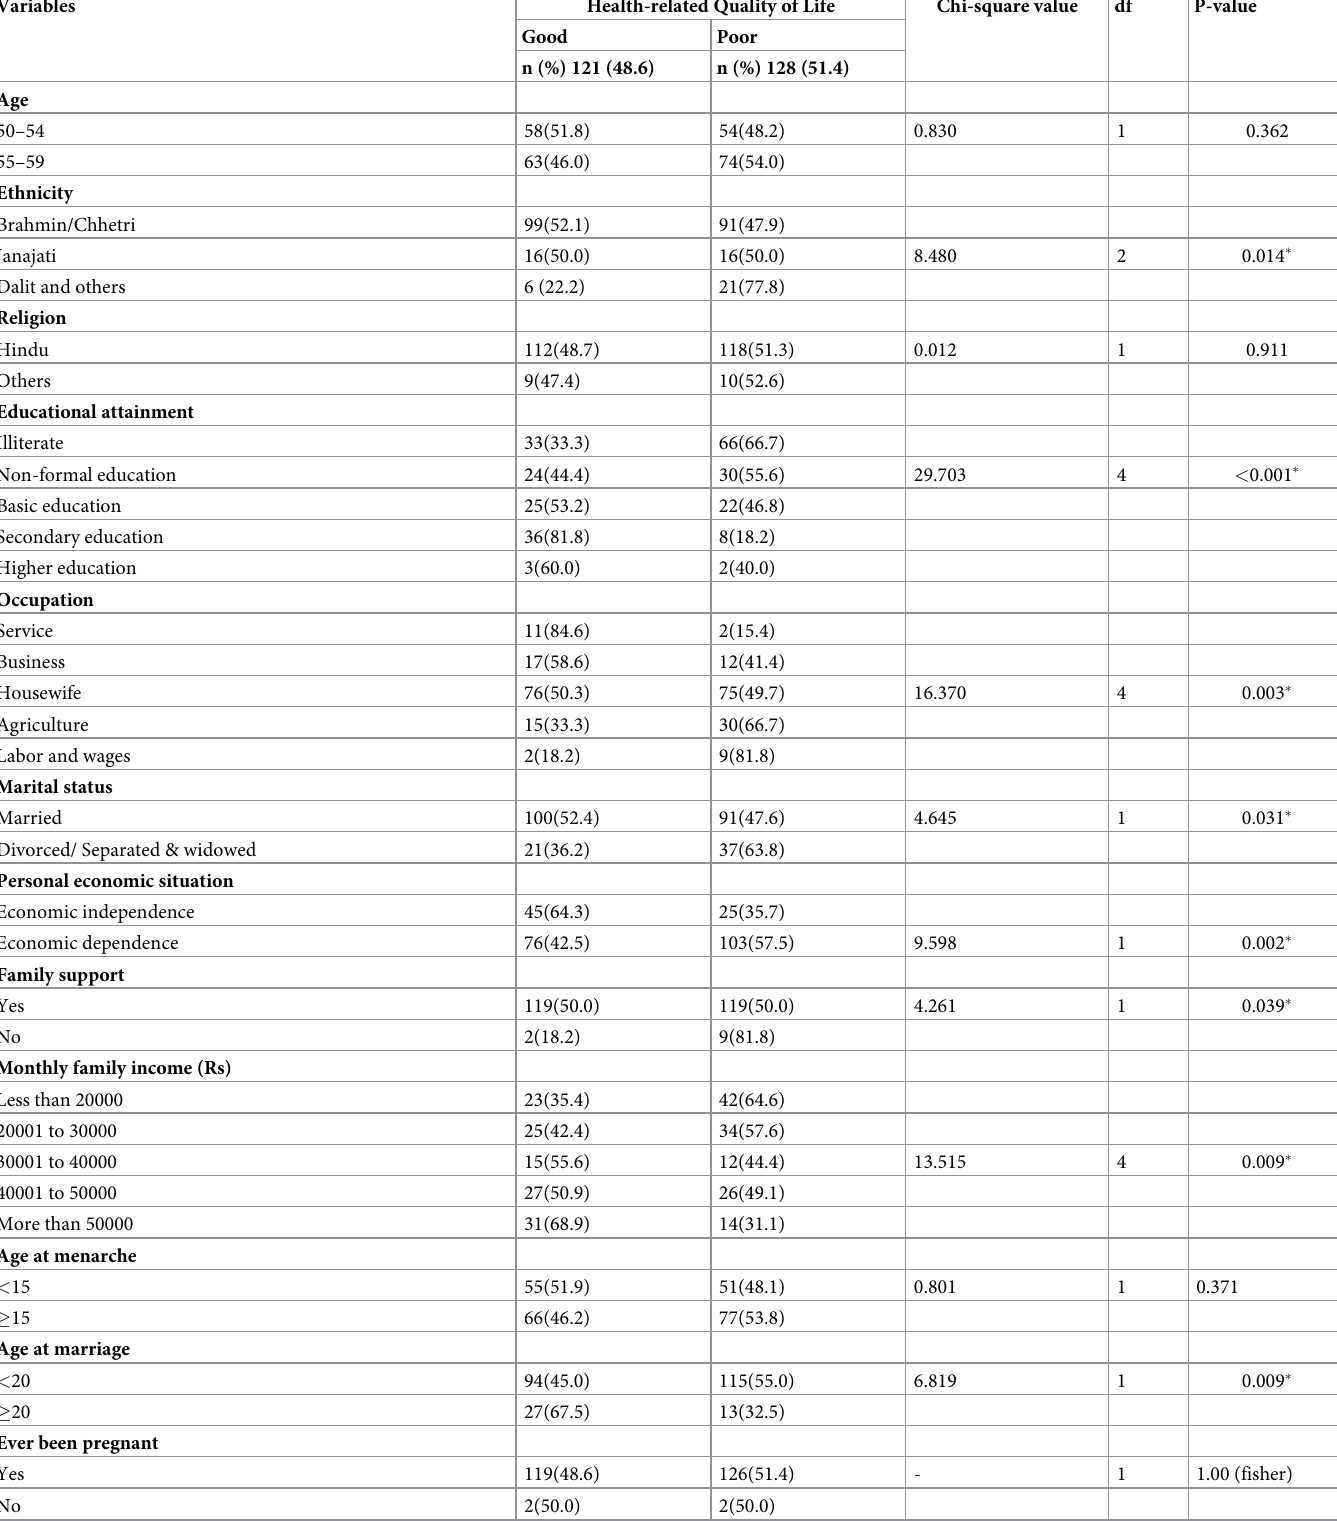
Table 4. Association of socio-demographic, obstetric, lifestyle-related variables and health problems of the participants with quality-of-life